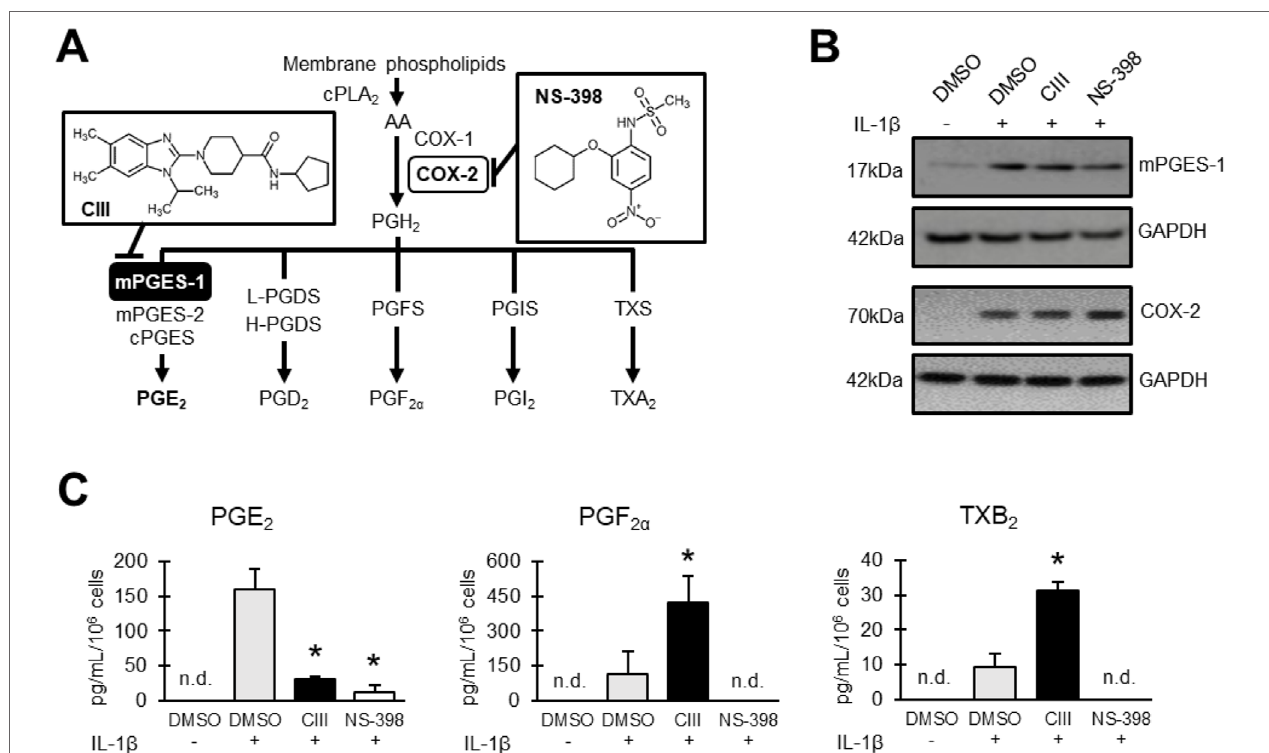
FIGURE 1 | Effect on prostanoid production by CIII and NS-398. (A) Schematic overview of prostanoid biosynthesis. Arachidonic acid (AA) is released from phospholipids in cell membranes by action of cPLA 2 and then converted into PGH 2 via COX-1/2 enzymes. The key terminal enzyme for PGE 2 production during inflammatory conditions is mPGES-1. Inserted molecules are mPGES-1 inhibitor CIII and COX-2 inhibitor NS-398. (B) Representative Western blot showing induced expression of mPGES-1 and COX-2 with IL-1 β in A549 cells. (C) Effect on prostanoid production as quantified in A549 cell supernatant with LC-MS/MS. Results are presented as mean ± SD ( n = 3) for one experiment. Statistical significance was tested using ANOVA followed by individual t test with Bonferroni correction ( p < 0.05). The asterisk (*) represents significance to IL-1 β . n.d = not